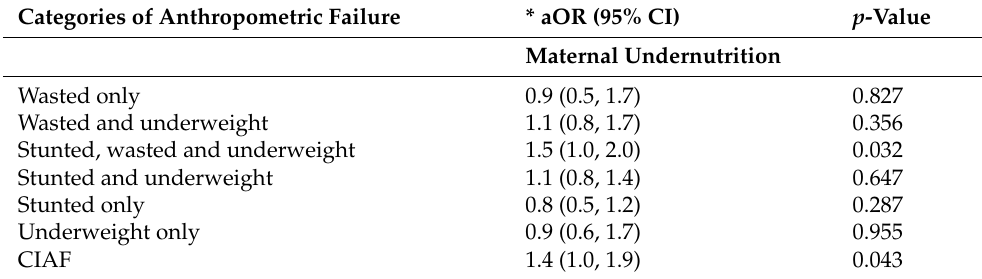
Table 5. Association between different anthropometric failure categories and maternal